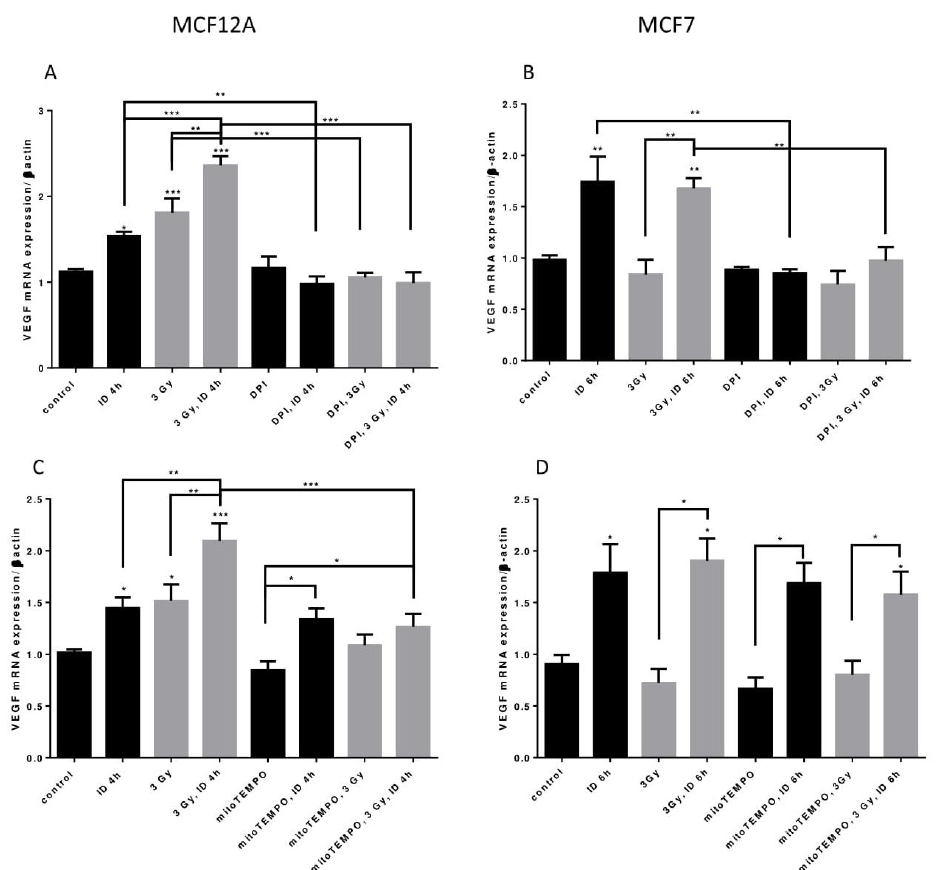
Figure 7. ID and radiations-induced VEGF mRNA up-regulation depends on cellular ROS production from different origins. Cells were cultured in iodine-containing medium for 7 days. Medium was replaced by iodine-containing (control) or iodine deficient (ID) medium and cells were then irradiated with a dose of 3 Gy. Part of the cells was treated with DPI ( A , B ) or mitoTEMPO ( C , D ). Cells were harvested 4 or 6 h after medium change. VEGF mRNA expression in MCF12A (A, C) and MCF7 cells (B, D) was determined using RT-qPCR. Data are expressed as means ± SEM. p -value < 0.05 were considered as statistically significant. * p < 0.05, ** p < 0.01, *** p < 0.001. Statistical test: one-way ANOVA